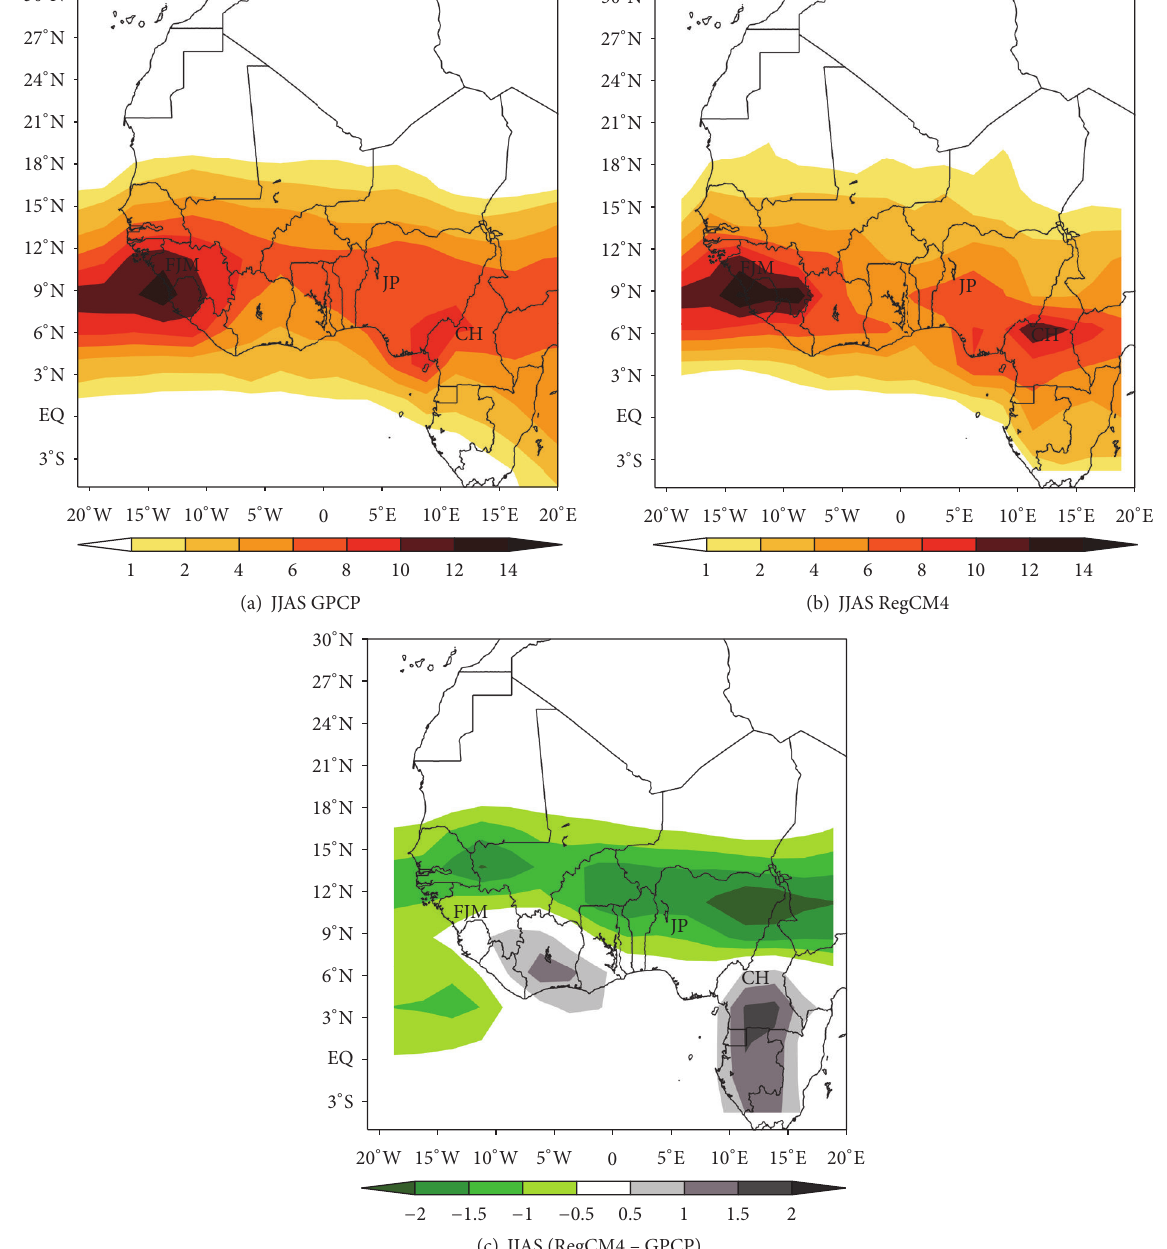
Figure 3: Mean summer rainfall (mm/day) averaged from 2003 to 2009 over West Africa: (a) GPCP climatology, (b) RegCM4, and (c) RegCM4 –